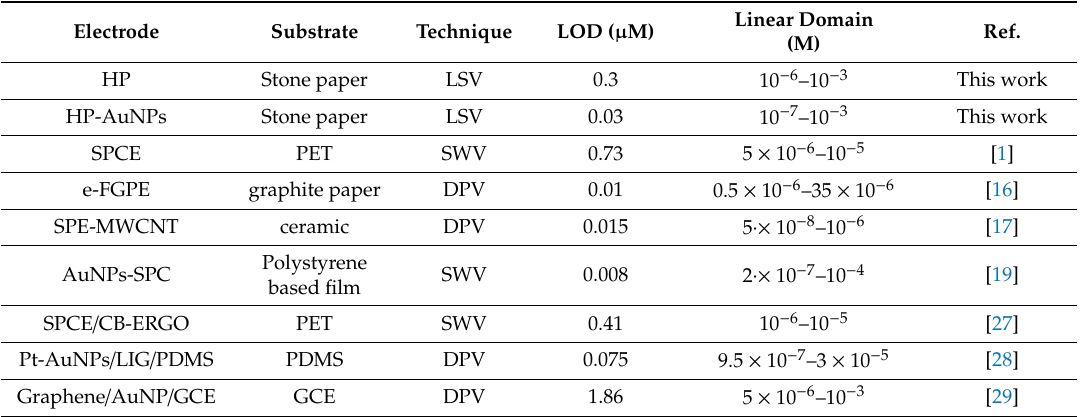
Table 2. Analytical performances of HP and HP-AuNPs electrodes for dopamine (DA) detection compared with other types of electrode.